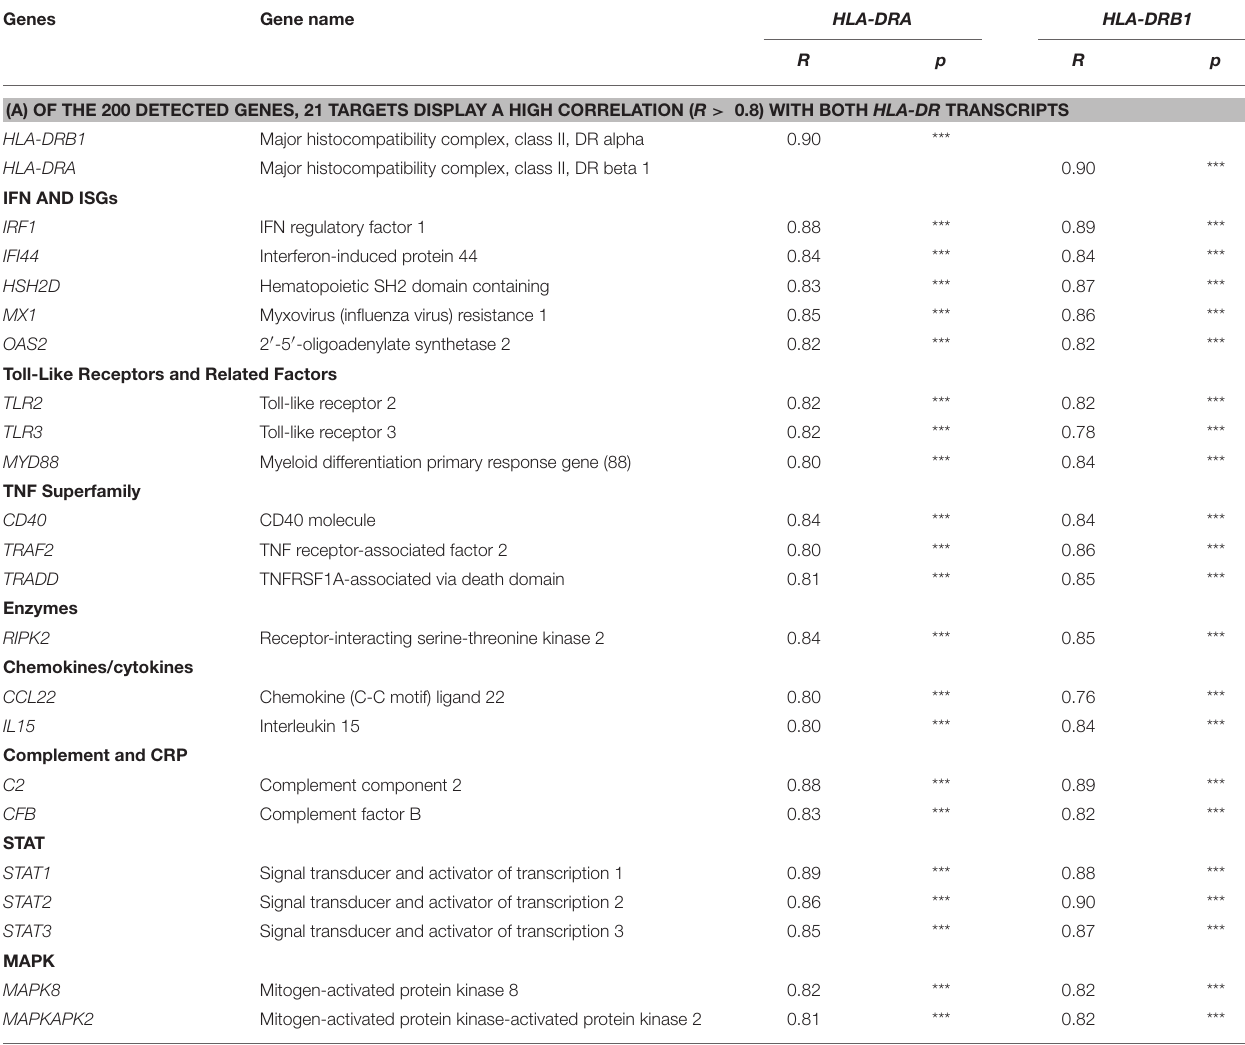
TABLE 3 | Selected inflammatory targets displaying a high correlation with HLA-DRA and HLA-B1 in conjunctival cells.